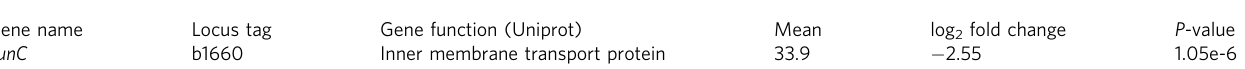
Table 1 RNA-Seq measurements for the differentially expressed gene, punC in punR deletion mutant strain compared to the E. coli MG1655 wild-type